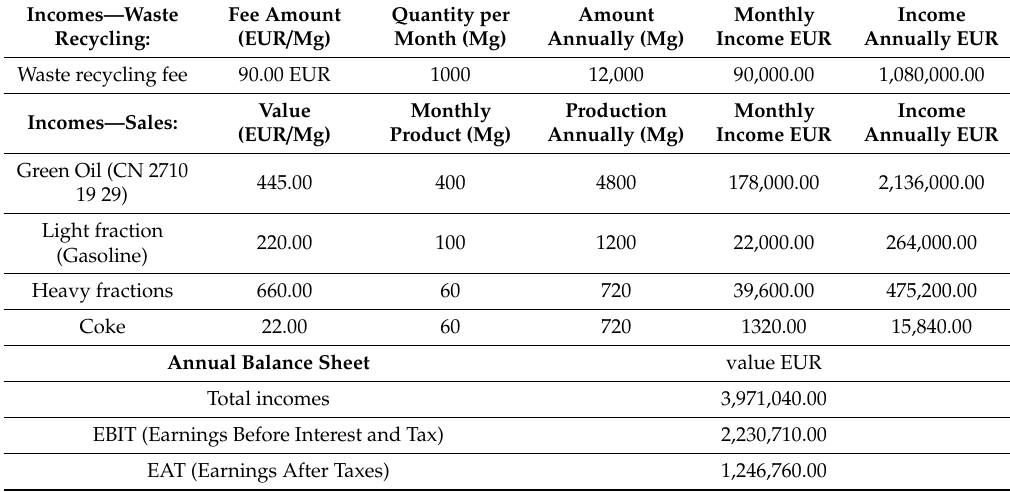
Table 4. A brief economic balance of the